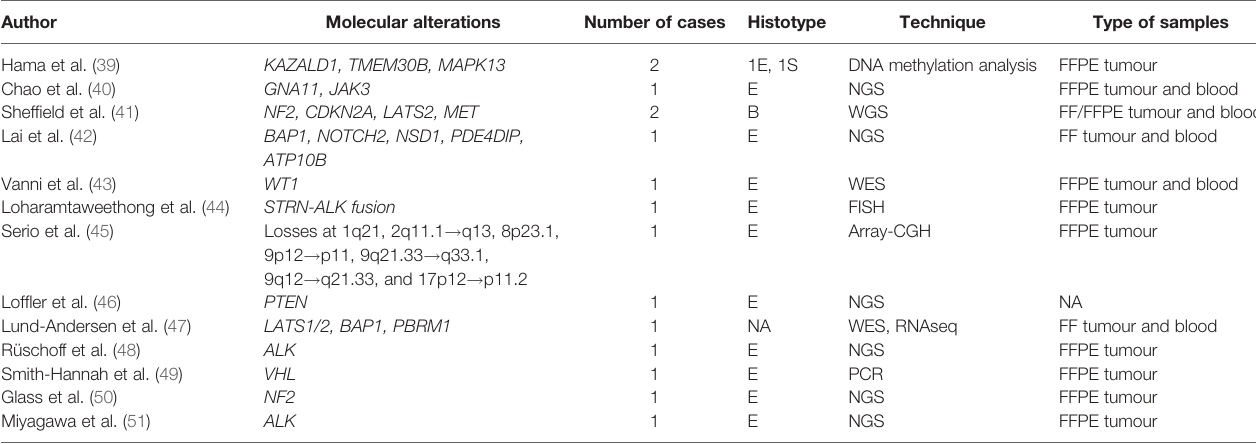
TABLE 2 | Previous published case reports with molecular studies.